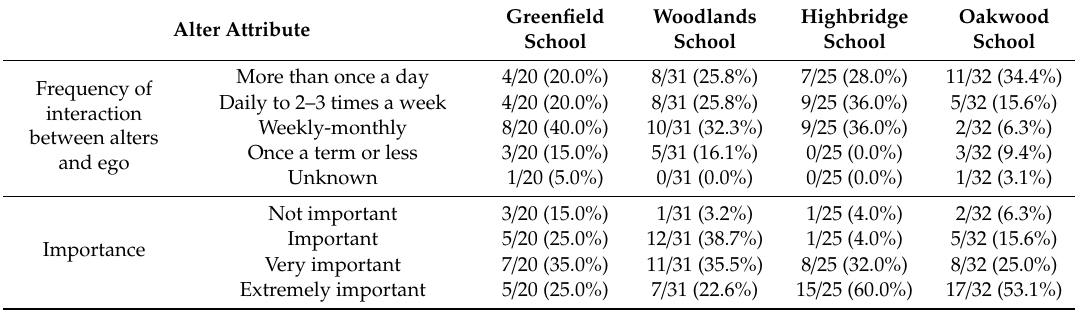
Table 5. Characteristics of Wellbeing Leads’ health and wellbeing-related ego networks.